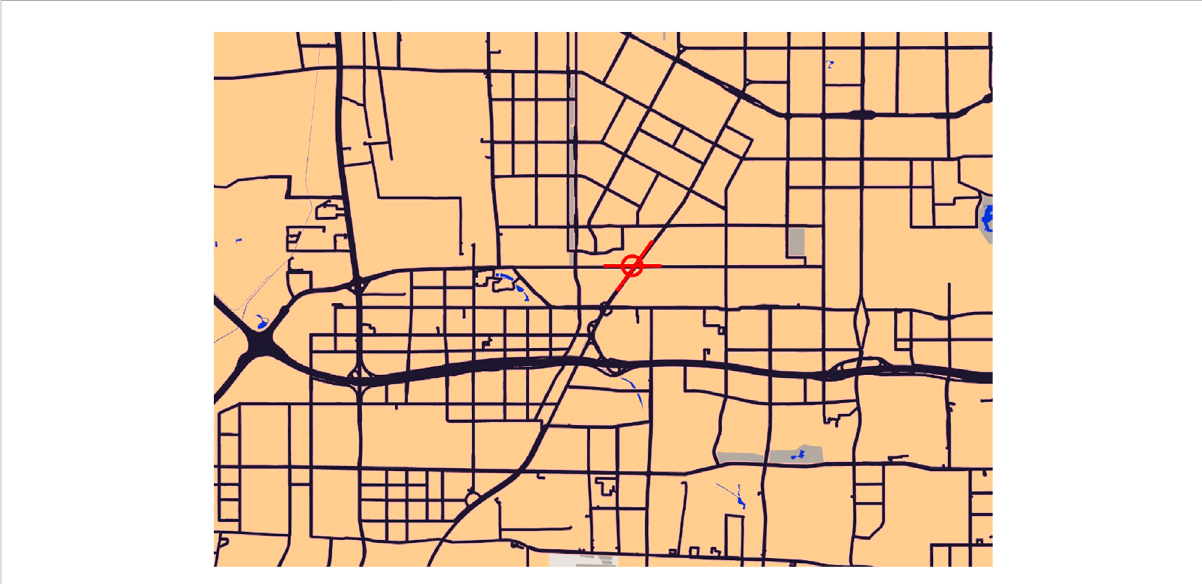
FIGURE 3 Theinvestigatedintersectionlocationscheme.Theinvestigationsectionintersectionisafour-leggedintersectionwithunconventionaloutside left-turn lanes, located in the center of Xi ’